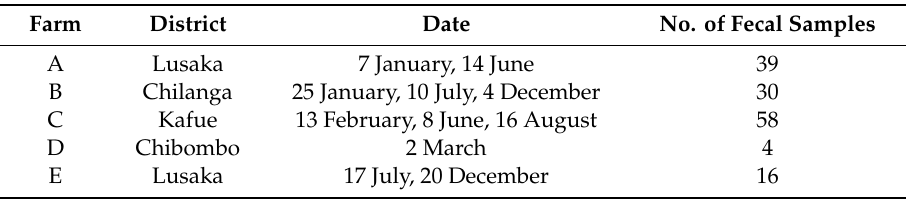
Table 1. Summary of sampling in 2018 in